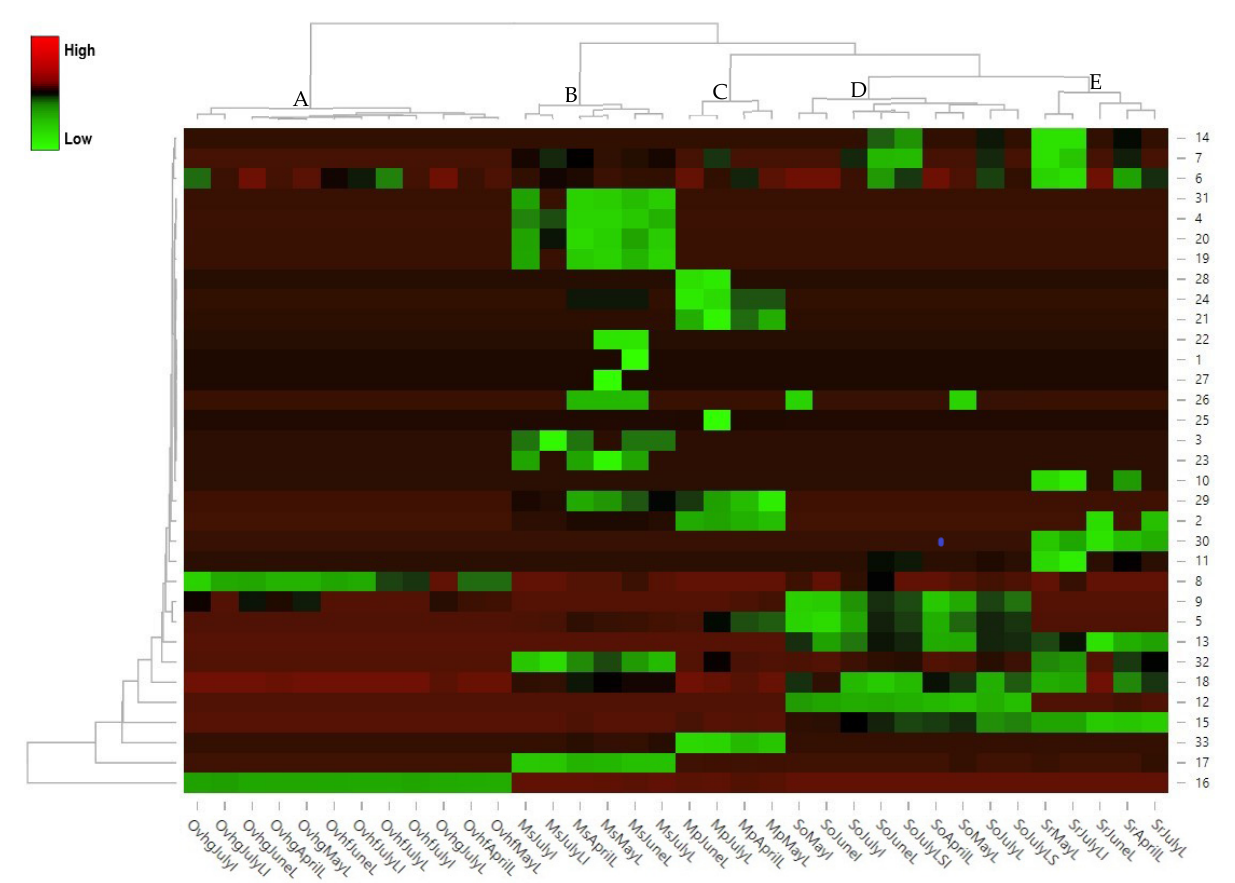
Figure 7. Hierarchical cluster analysis (HCA) and heatmap of all the essential oils’ data combined, based on their volatile compounds. Five clusters were formed. Cluster A comprised the O. vulgare subsp. hirtum oil samples, both from field and greenhouse, cluster B comprised the M. spicata oil samples, cluster C the M. × piperita oil samples, and clusters D and E comprised the S. officinalis and S. rosmarinus oil samples, respectively. Heatmap cells are colored according to the percentages of the main volatile compounds.